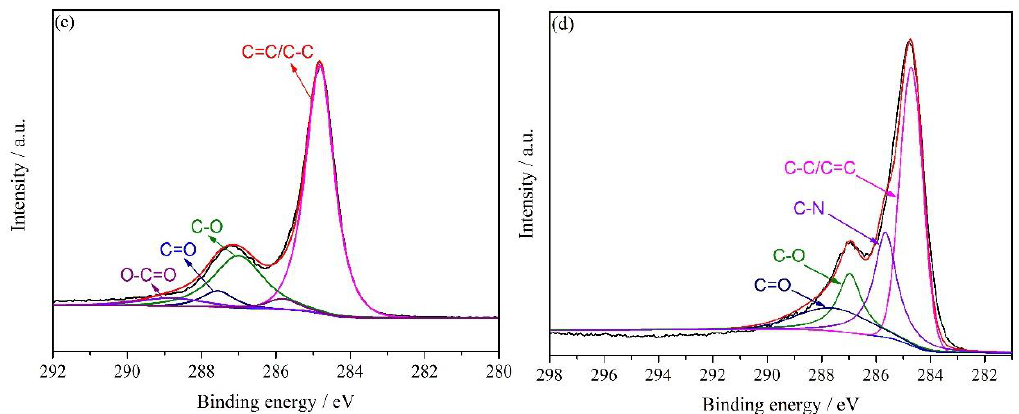
Figure 7. The X-ray photoelectron spectroscopic (XPS) spectra of GO and HNH-rGO: all elements survey scan of GO ( a ), HNH-rGO ( b ), C 1s survey scan of GO ( c ) and HNH-rGO ( d ).